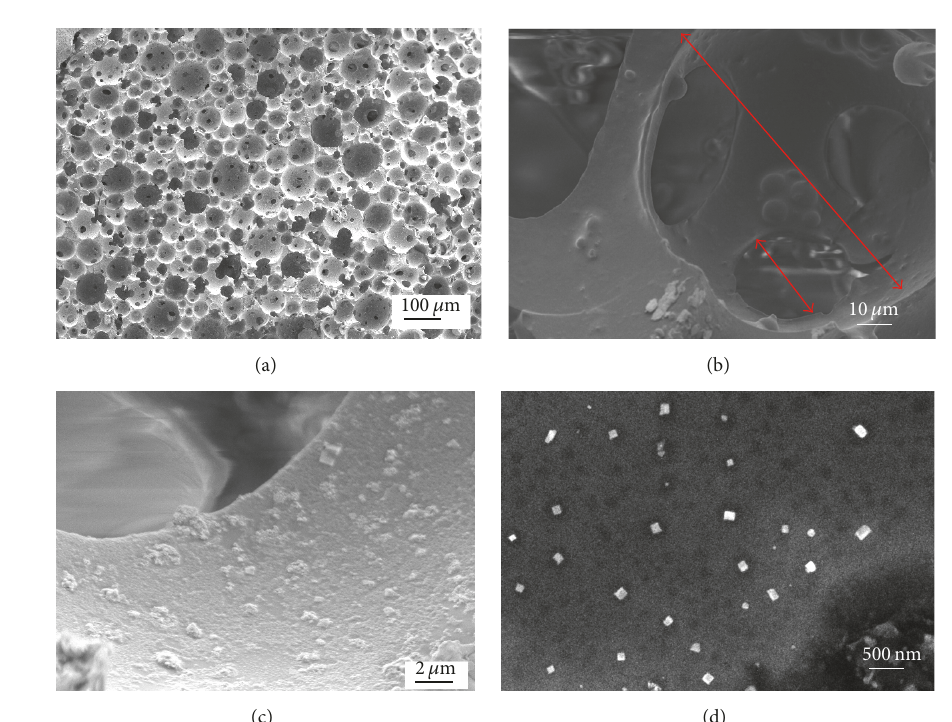
Figure 2: SEM micrographs of (a) PC-polyHIPEs; (b) enlarged PC-polyHIPEs; (c) Sr 0.7 K 0.3 TiO 3−𝛿 @PC-polyHIPEs; (d) Sr 0.7 K 0.3 TiO 3−𝛿 . The long red arrow in Figure 2(b) shows that the PC-polyHIPEs own ca. 100 𝜇 m pores and the short red arrow shows that the PC-polyHIPEs own ca. 30 𝜇 m